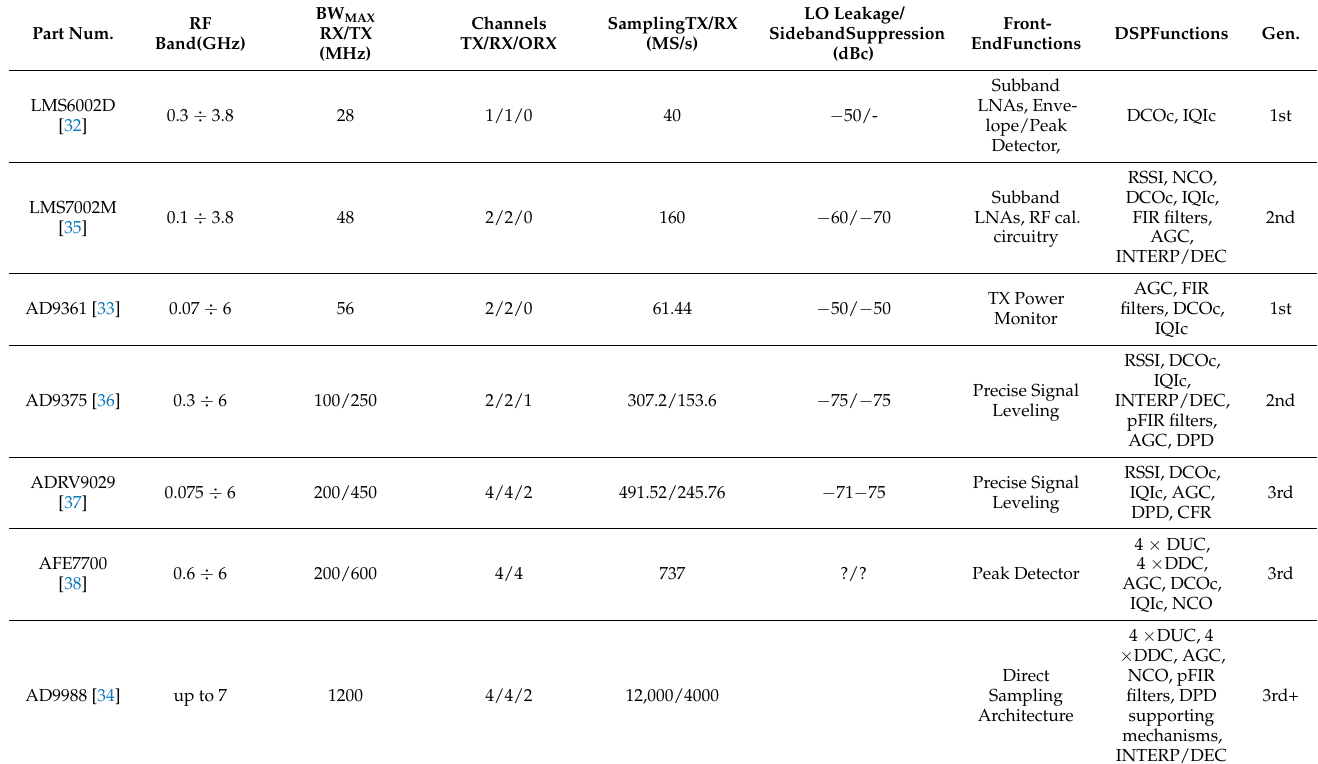
Table 1. Integrated transceivers recommended for SDR system